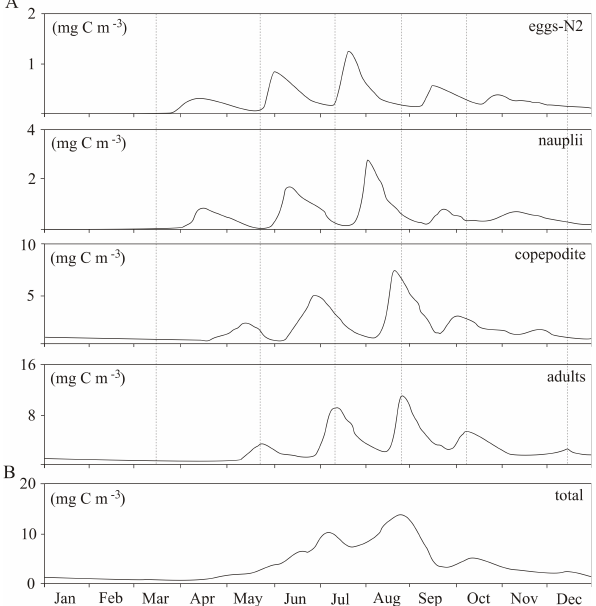
Fig. 6. Simulated Acartia spp. generations (A) vertical mean biomasses of eggs, nauplii, copepodites and adults (mgCm − 3 ), (B) total biomass as vertical mean